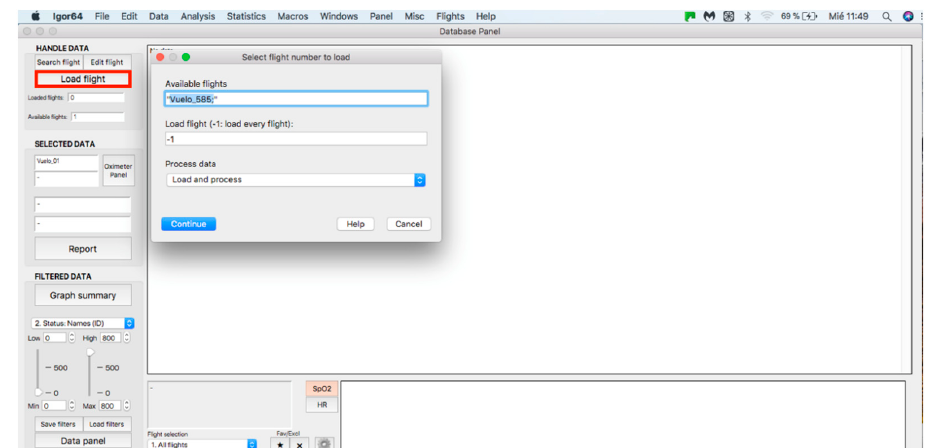
Figure 5. Flight selection from the database.